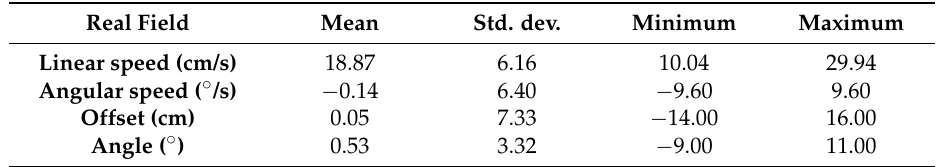
Figure 20. Tests in a real field: ( a ) Evolution of the linear speed of the robot. ( b ) Evolution of the angular speed of the robot. ( c ) Evolution of the offset of the robot relative to the line. ( d ) Evolution of the angle of the robot relative to the line. Table 6. Results obtained in a real